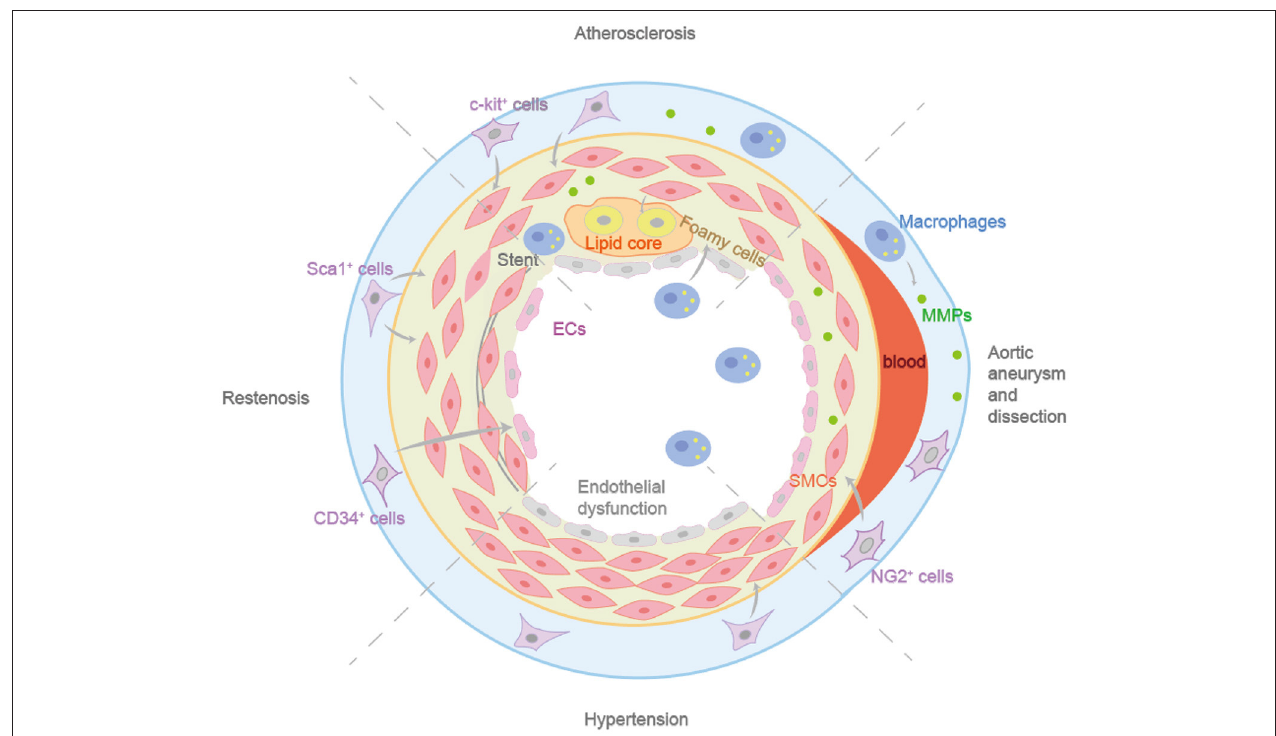
FIGURE 3 | The different roles in vascular remodeling diseases of vascular progenitor cells. c-Kit + cells can differentiate into ECs and participate in endothelial homeostasis. Sca-1 + progenitor cells in adventitia can enhance the formation of neointima. Non-bone marrow CD34 + cells could differentiate into ECs after femoral artery injury, maintaining vascular integrity and preventing the formation of neointima. Resident NG2 + progenitor cells can differentiate into VSMCs after aortic injury during aortic aneurysm and